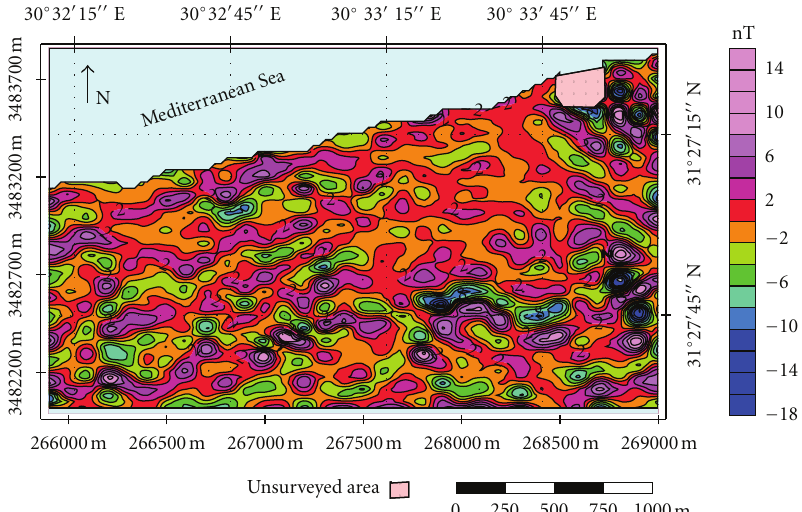
Figure 8: Filled colour contour map of the residual component of magnetic-field intensity of Koam Mashaal area, East Rosetta, Mediterranean Sea Coast, Northern Egypt at an average depth ( h ) of 81.8 m, contour interval =